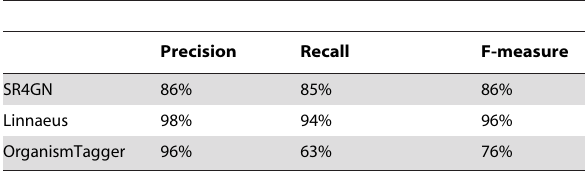
Table 1. Evaluation on species detection using the Linnaeus corpus from.